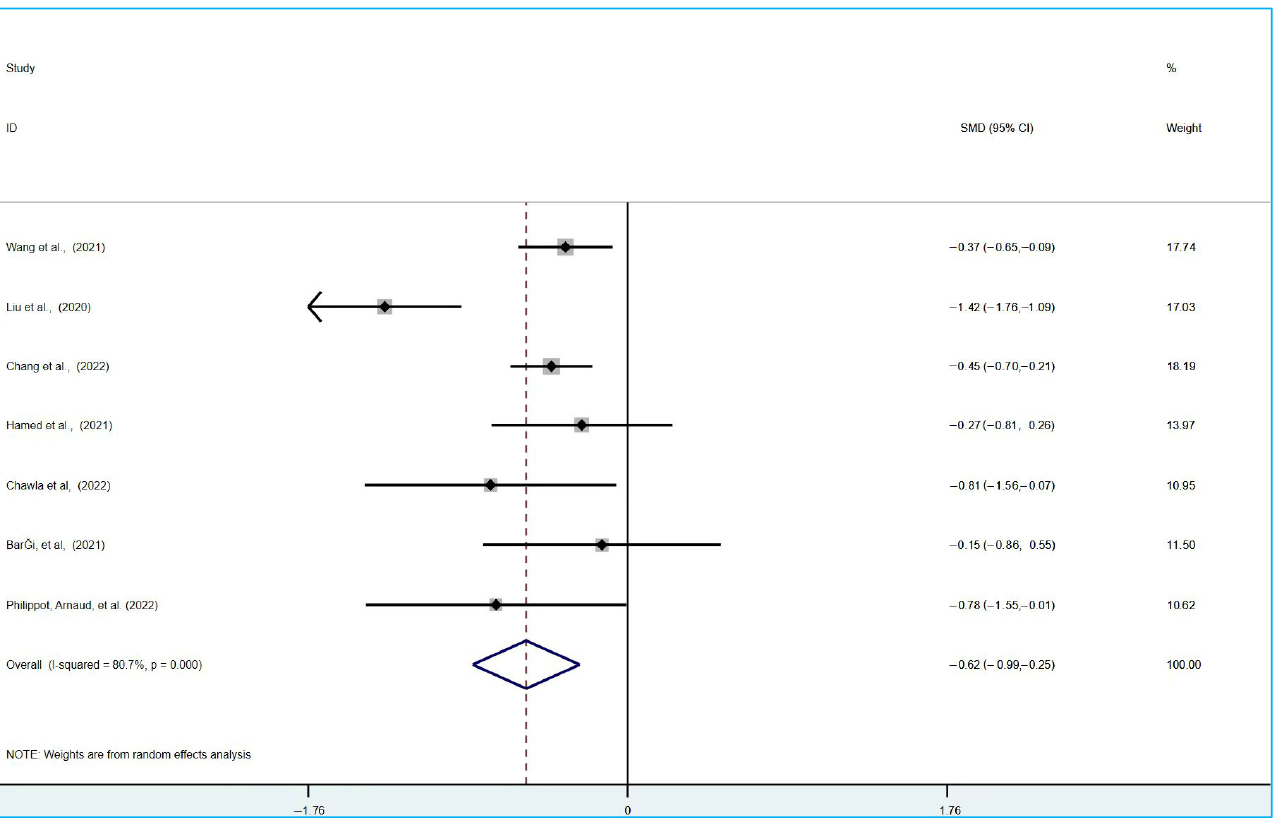
Figure 4. The Influence of Physical Activity on University Students’ Depression [58–65].